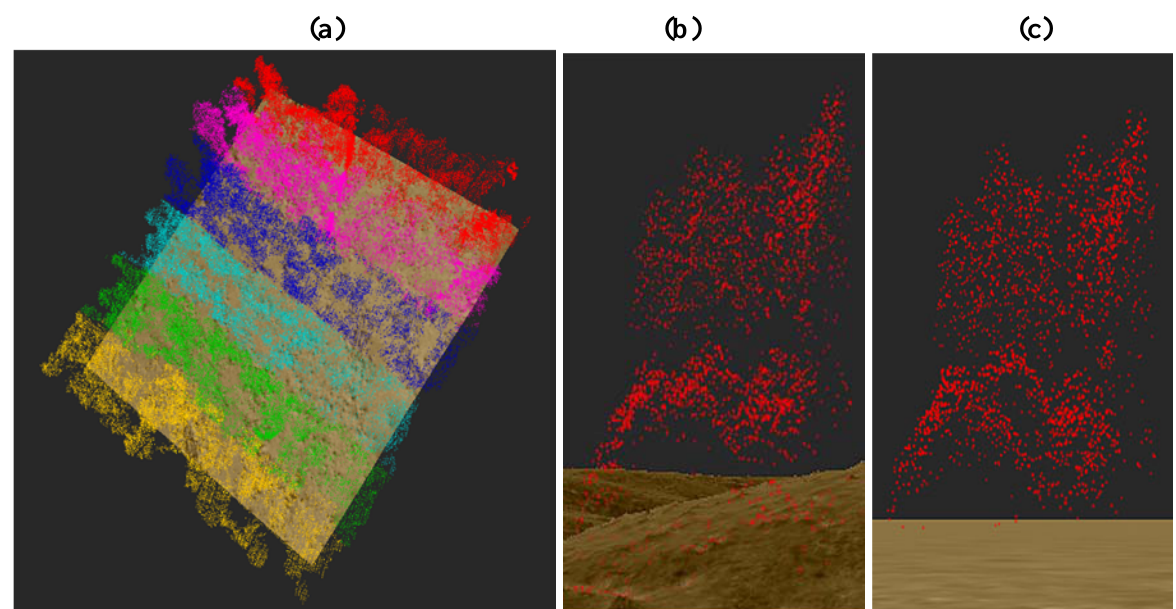
Figure 3. LIDAR raw and normalized points. (a) LIDAR raw points of the whole test area projected above DTM. (b) LIDAR raw points above DTM in a closed view. (c) Normalized points above zero height in a closed